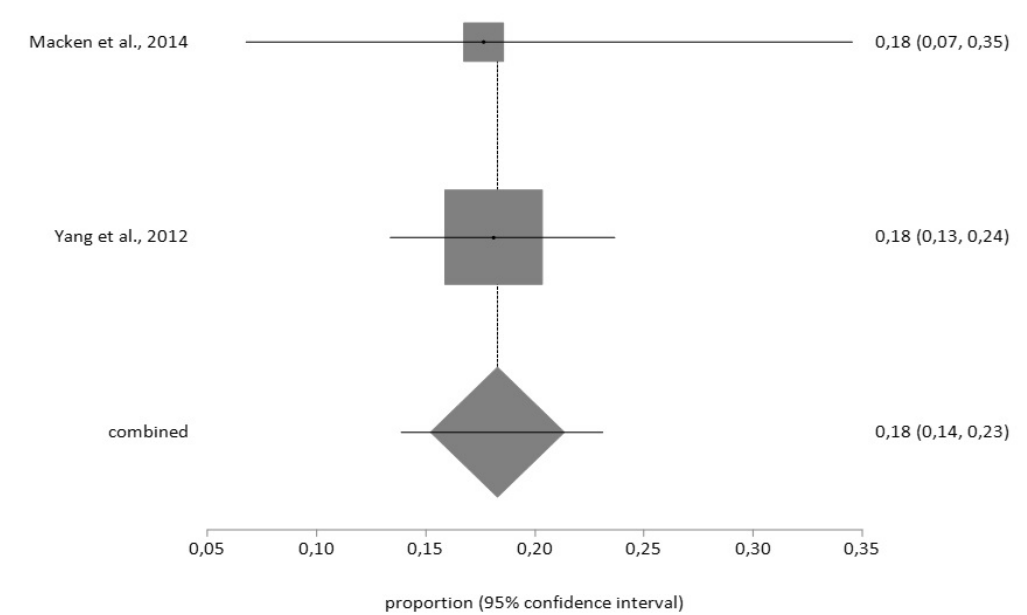
Figure 7. Forest plot for post-CABG depression using PHQ-9.